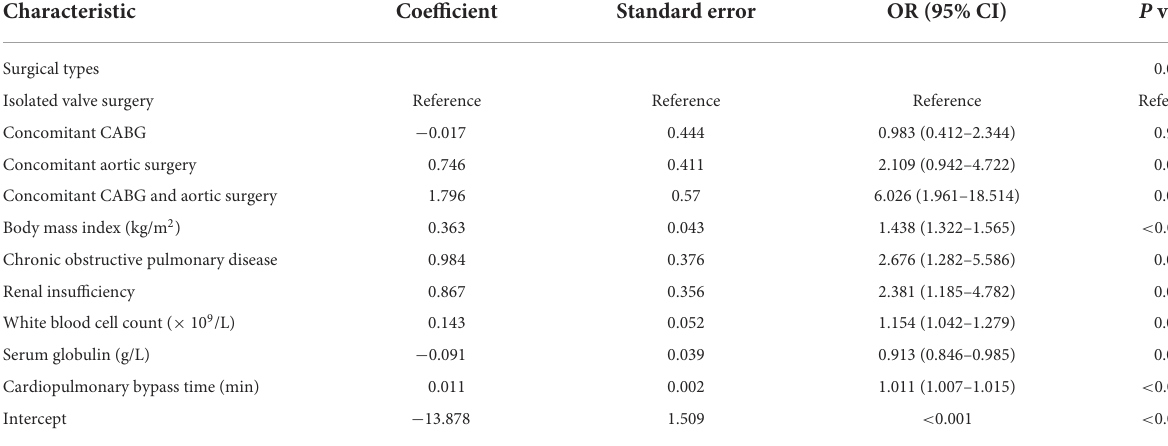
TABLE 2 Multivariate analysis of independent risk factors for SH following HVS.